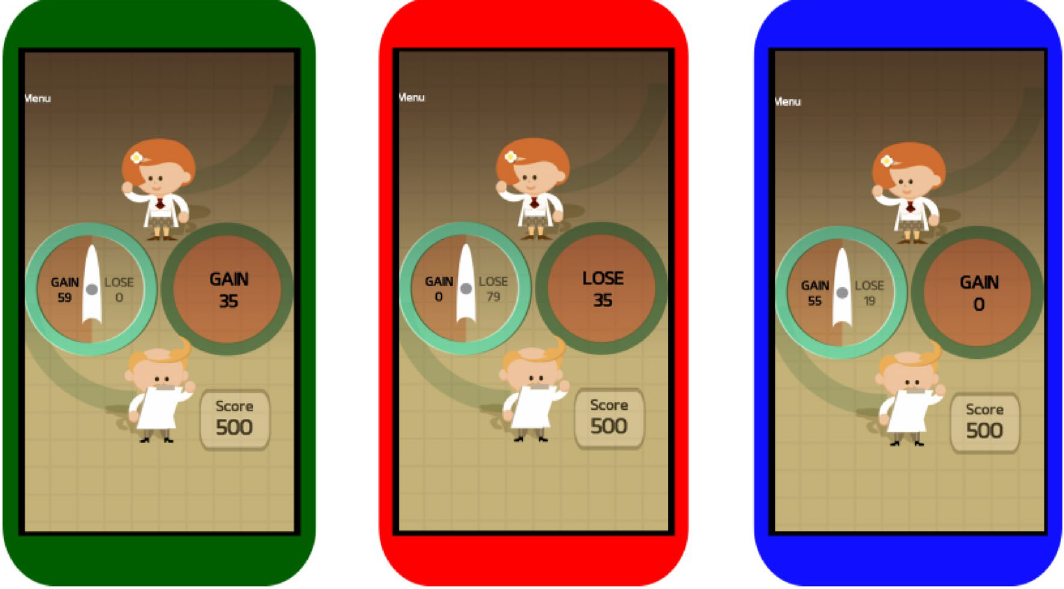
Figure 1. Task Design. Gain trials (green outline) had potential gains and no potential losses. In an example gain trial, a participant chose between a risky option (here, 50% probability of 59 points) and a safe option (here, 100% probability of 35 points). Loss trials (red outline) had potential losses and no potential gains. Mixed trials (blue outline) had both potential gains and potential losses with a safe option that was always worth 0 points. Therefore, on any trial participants could opt for a risky choice. The experimental design enables the role of a gain or loss magnitudes in propensity towards risk to be disambiguated. The participants total score, starting at 500 points, was added or taken away from throughout the game as they win and lose points on each risky choice. The green, red, and blue outlines were added to the figure for descriptive purposes, each trial had the same appearence to the